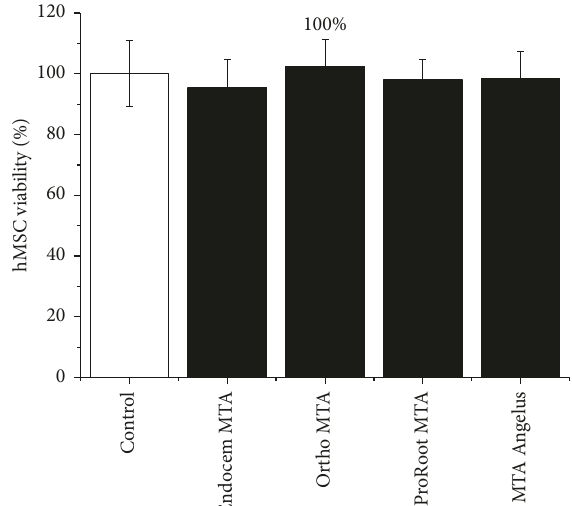
Figure 2: Results of cell viability of hMSCs at the 100% concentration of extracts from each MTA after setting. ∗ P < 0 . 05 and ∗∗ P < 0 . 01 indicate statistically significant differences between cements and the control group. Each extract from four kinds of MTA after setting showed no cytotoxicity compared to control ( P > 0 . 05).